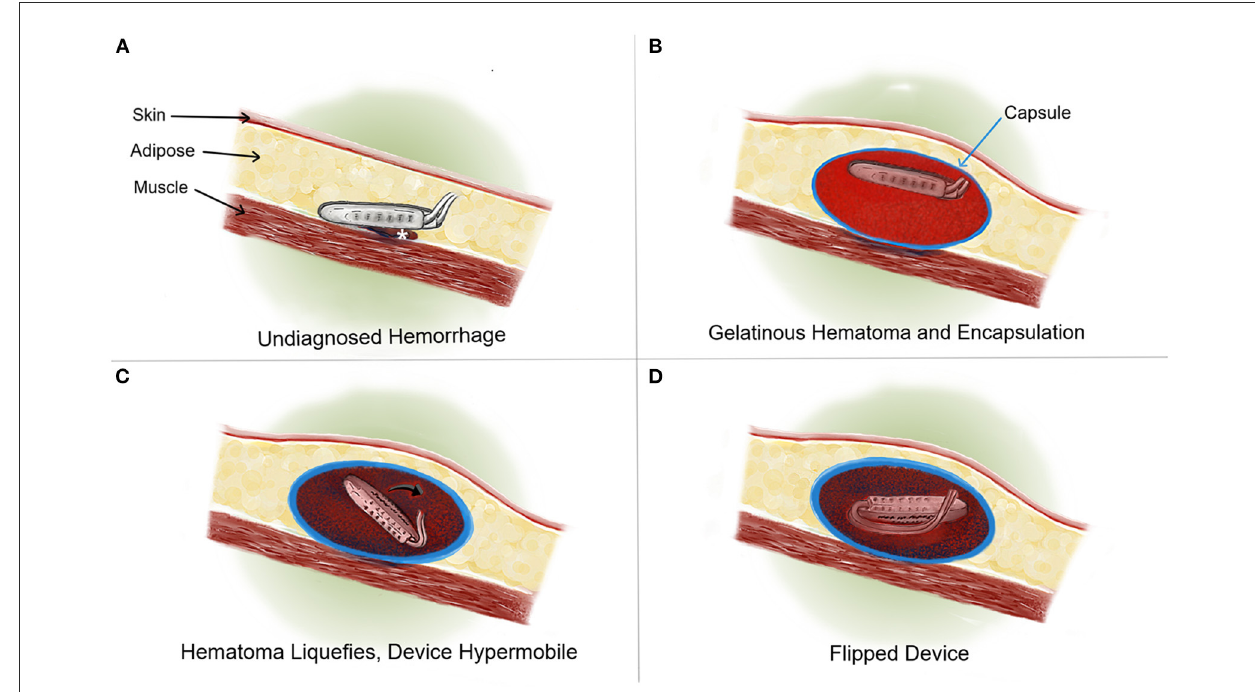
FIGURE2 Cross sectional rostral to caudal view medical illustration. (A) An example of an IPG implanted with a resulting bleed (*). (B) Formation of a solid, gelatinous clot which expands until cessation of bleeding. A fibrous capsule is formed around the IPG and clot over the course of several weeks. At this time the IPG remains in appropriate orientation that facilitates interrogation and charging. (C) Over time, the blood clot evolves, breaking down into liquid blood. This scenario results in the hypermobility of the IPG ( → ) within a now enlarged and well-formed capsule. (D) The hypermobile IPG is “flipped” and cannot be charged by the patient or programmed by the